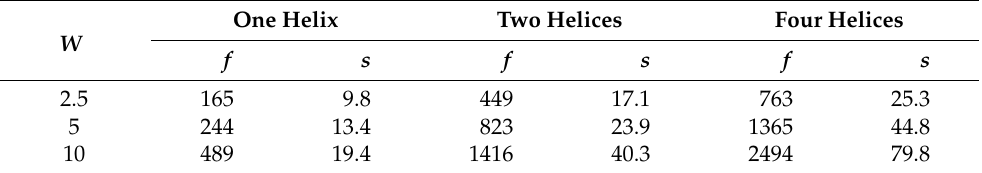
Table 2. The runtimes of evaluating f ( θ ) and s ( θ ) when the carpet consists of one, two, or four helices and the width of the flow meter (7) is 2.5, 5, or 10. One Helix Two W